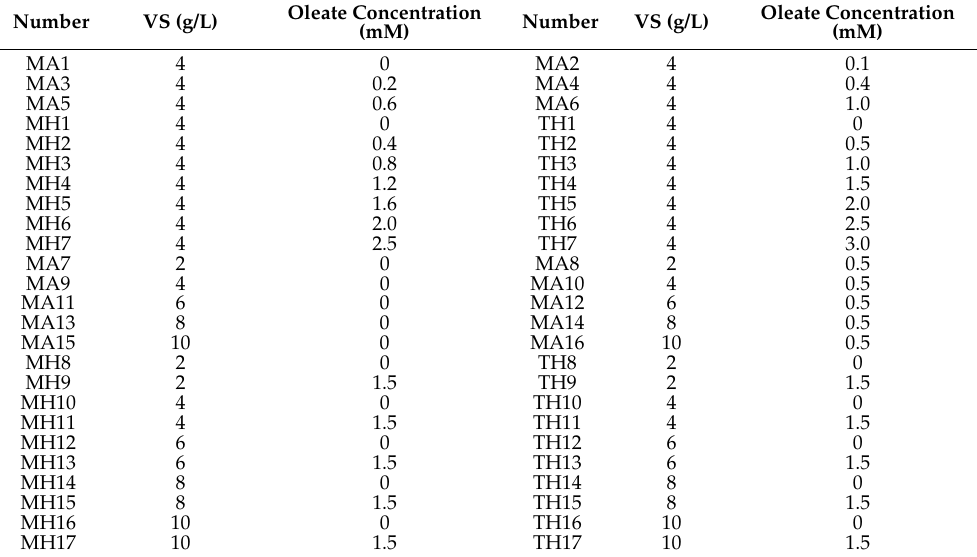
Table 1. Detailed experimental